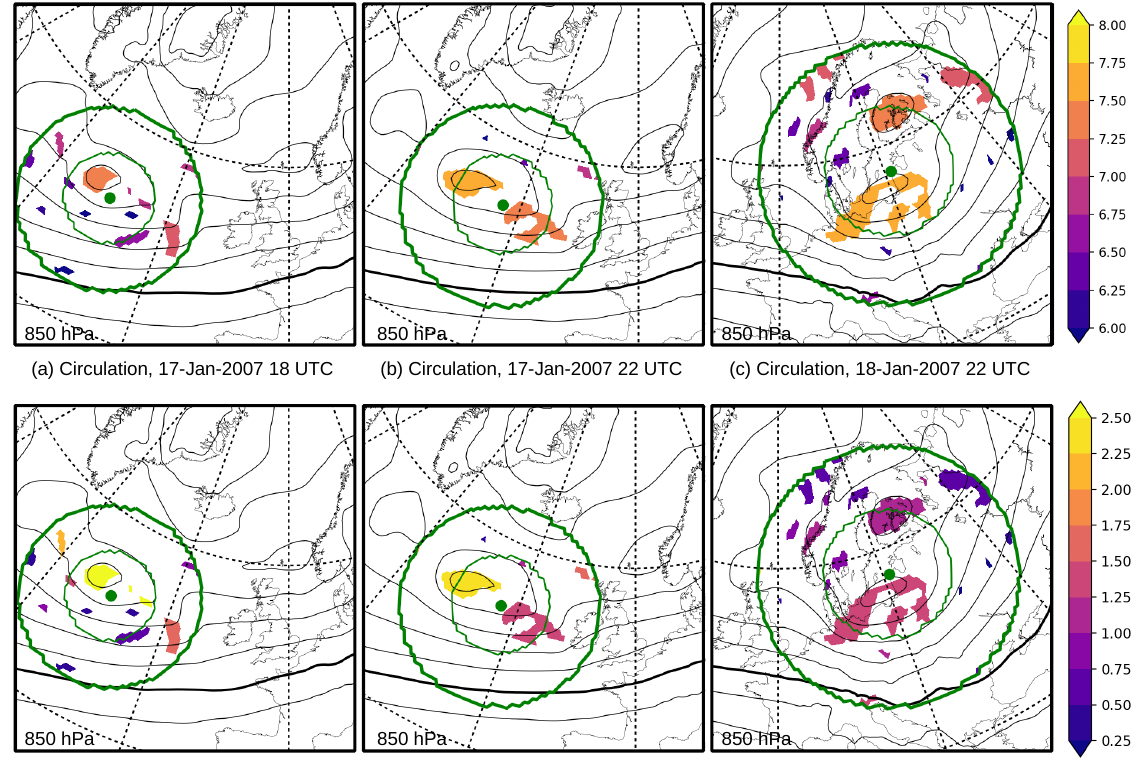
Figure 10. Vortices identified in CFSR data at 850 hPa for specific time steps color shaded ( a – c ) by their circulation magnitude (Log10(circulation (m 2 s − 1 ))) and ( d – f ) by their mean vorticity (10 − 4 s − 1 ). Other properties and contours as described in Figure 9, except the thick black contour, which is equal to a geopotential height of